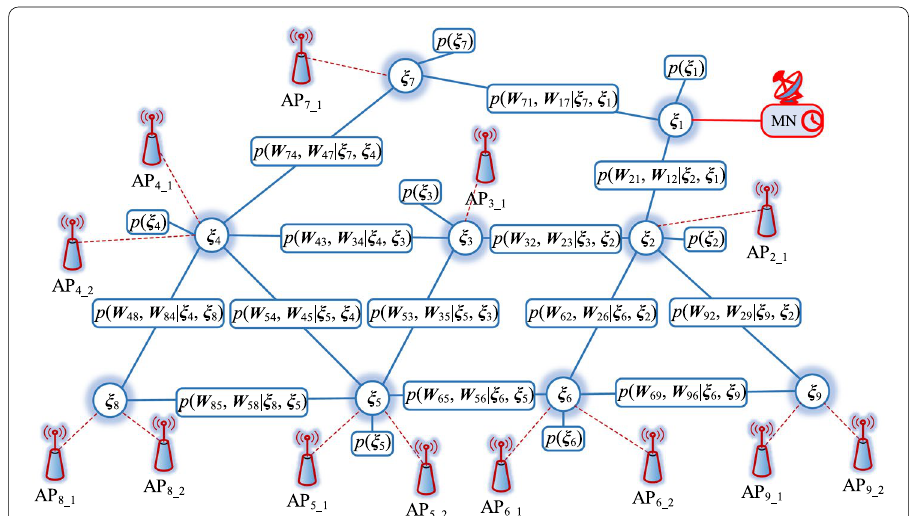
Fig. 4 The FG corresponding to an exemplifying network. Note that, the FG is drawn only for the backhaul network to avoid unnecessary complexity. To draw the FG of the whole network, one can simply consider APs as variable nodes connected to their corresponding backhaul nodes via factor